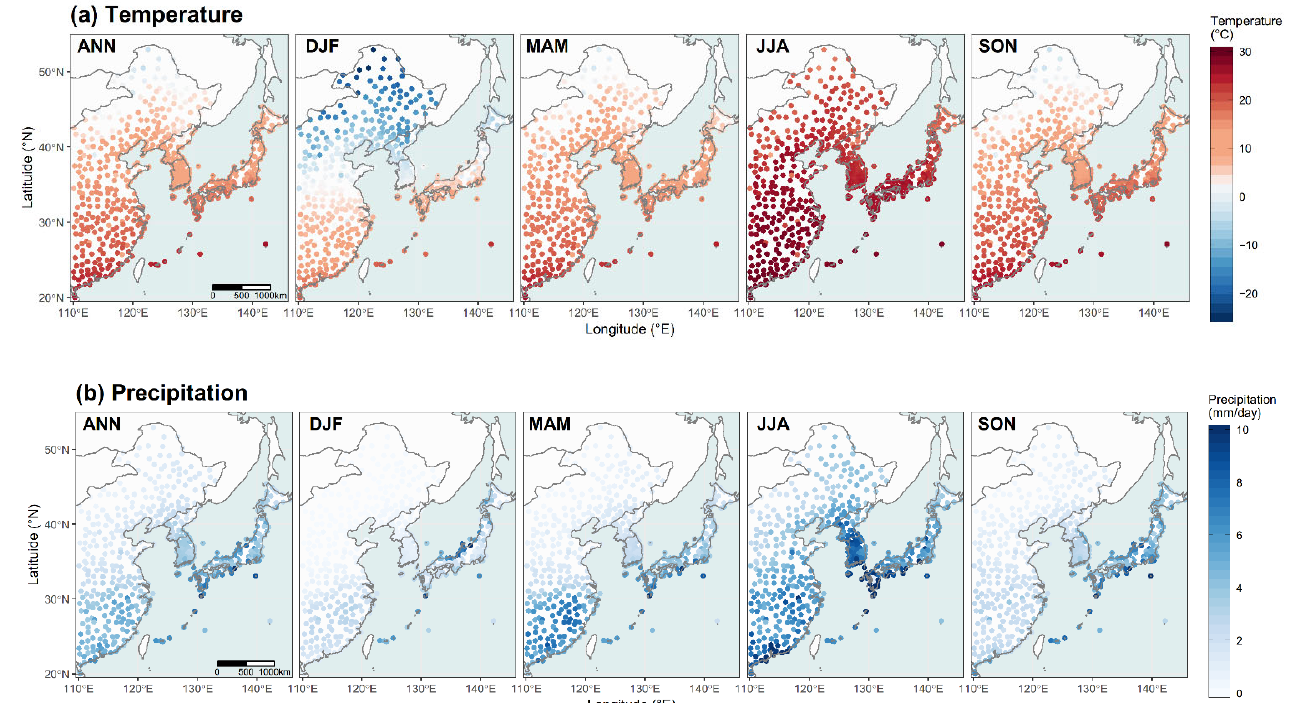
Figure 2. Climatology of ( a ) temperature and ( b ) precipitation from observation data at each station in the EAM region using the annual and seasonal (DJF, MAM, JJA, and SON) averages over the forty years of 1981–2020 for North Korea, South Korea, and Japan and the thirty years of 1981–2010 for China. The scale bar of temperature is in a range of − 25 to 30 °C and the midpoint of scale is at 2.5 °C.